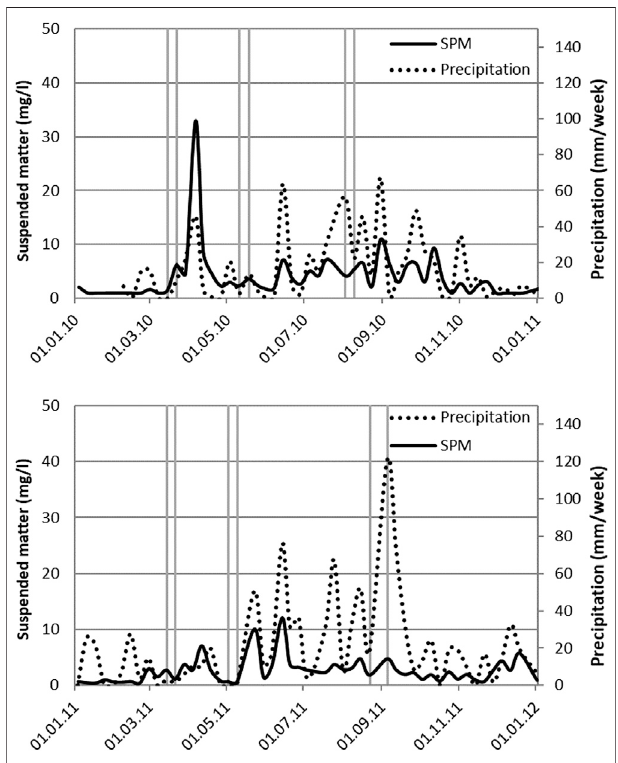
FIGURE 2 | Concentrations of suspended particulate matter (weekly timecompositesamples)intheAkerRiverduringthe2-yearmonitoringperiod of the study, weekly integrated precipitation data are indicated with dashed line(the intervals ofthe six sampling events are indicated with gray lines).